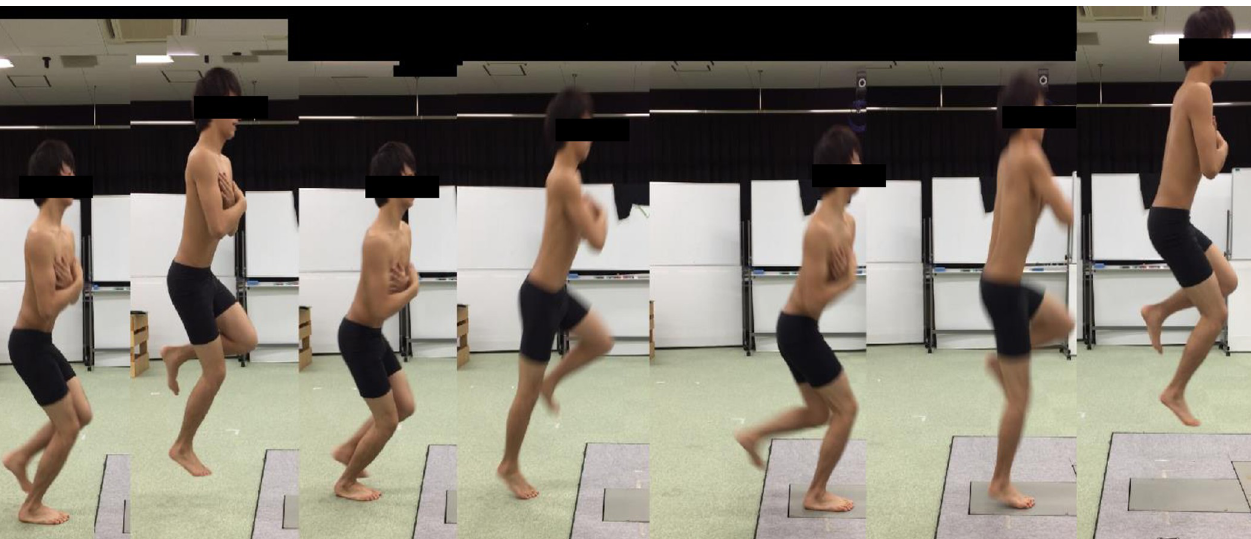
Fig 3. One leg rebound jump. Jumps consisted of four repeated rebound jumps in the vertical direction with a one-leg take-off from a standing posture. For rebound jump, the subjects were instructed to keep the contact time as short as possible and to jump as high as possible during the fourth jump. The fourth measurement was